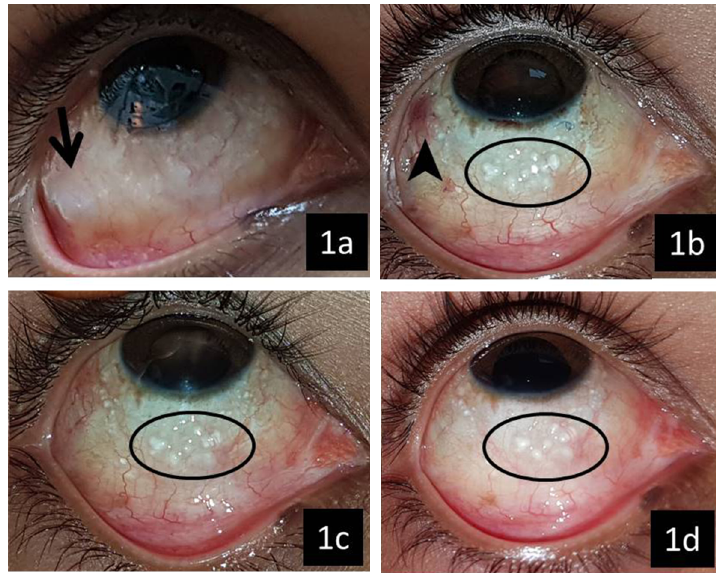
Figure 1: Pre- and postoperative clinical photographs of the conjunctiva of the right eye. 1a: Preoperative photograph showing diffuse congestion and bogginess of the conjunctiva. A large subconjunctival nodule in the inferotemporal area is marked with an